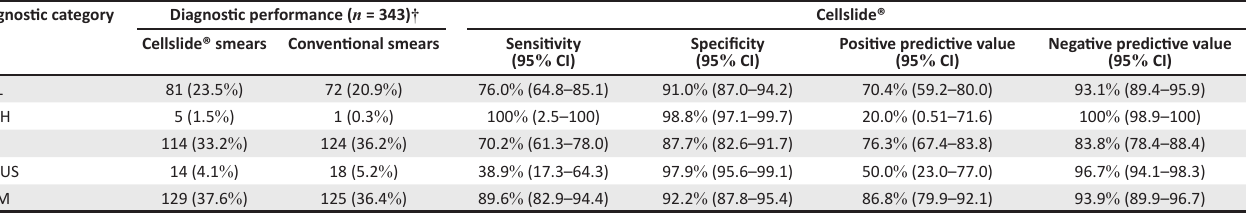
TABLE 3: Diagnostic accuracy of Cellslide® compared with conventional cytology in samples from HIV-positive women in Johannesburg, South Africa (November 2009 to August 2011). Diagnostic